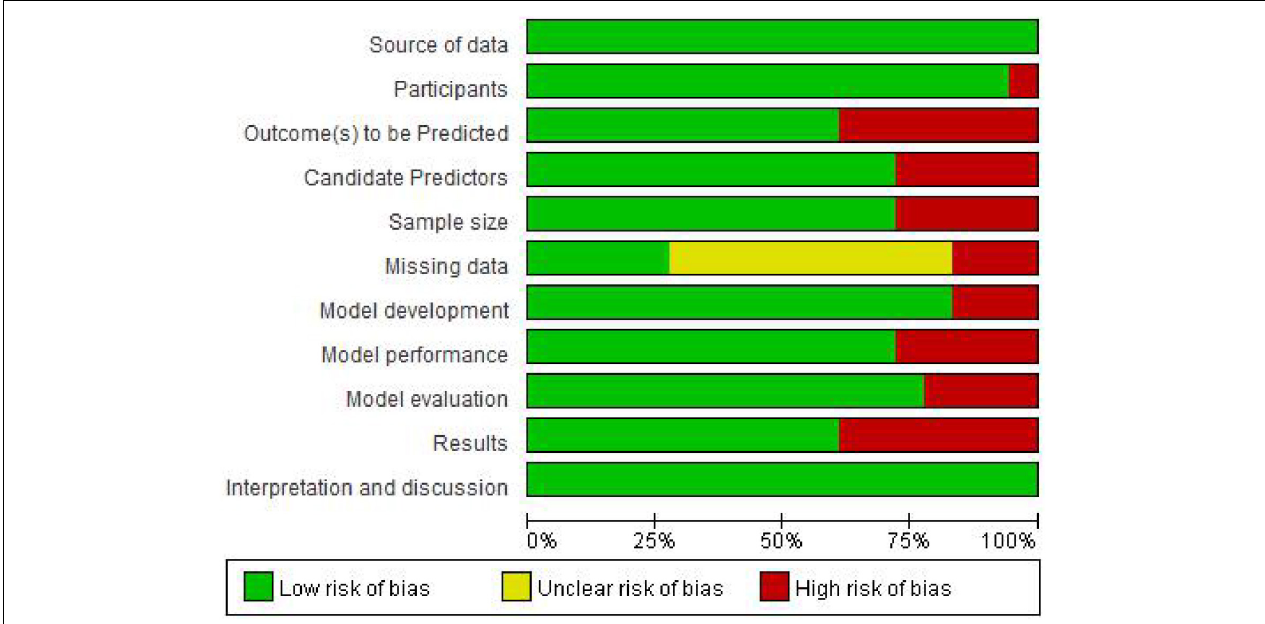
FIGURE 2 | Risk of bias assessment for included